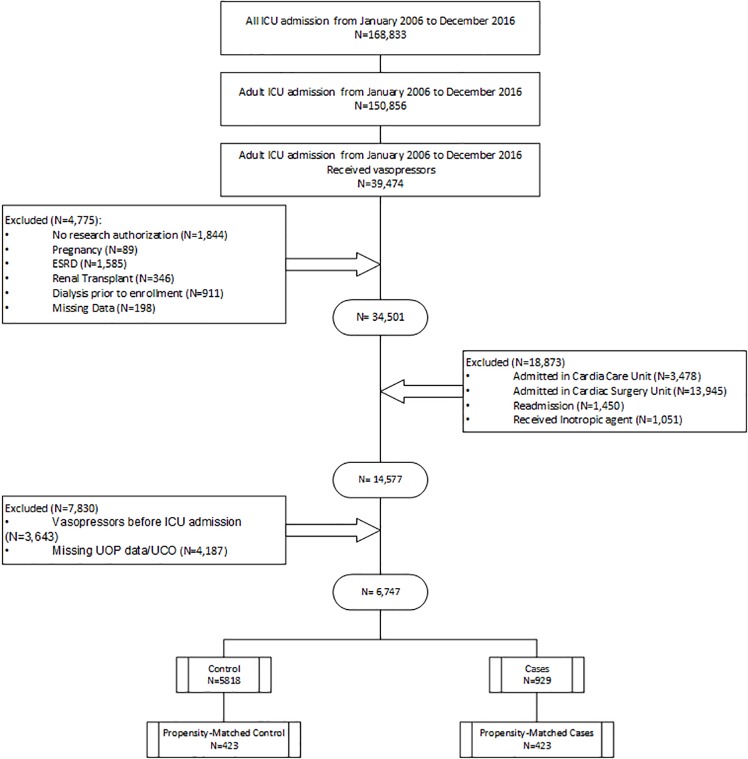
Patient enrollment flow chart.